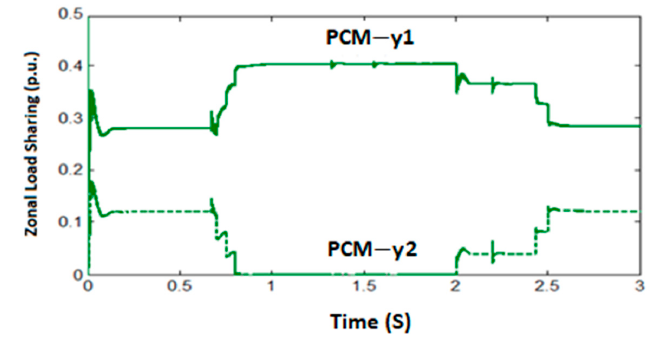
Figure 14. Load Sharing in zone 2.